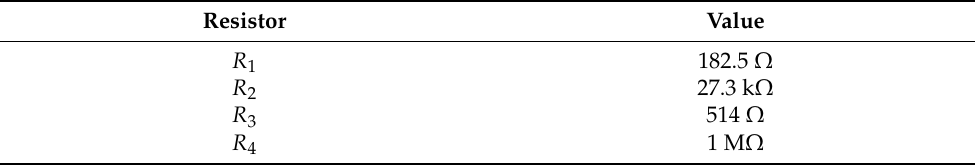
Table 8. CTD Wheatstone bridge architecture fixed resistors used in SPICE simulation.